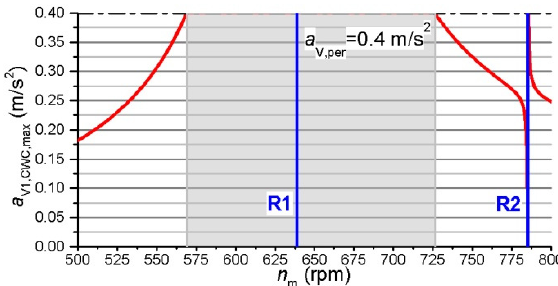
Figure 20. The FREM width of the resonant area R1 at the conditionally expanded span of the frequency regulation (lower limit 500 rpm).